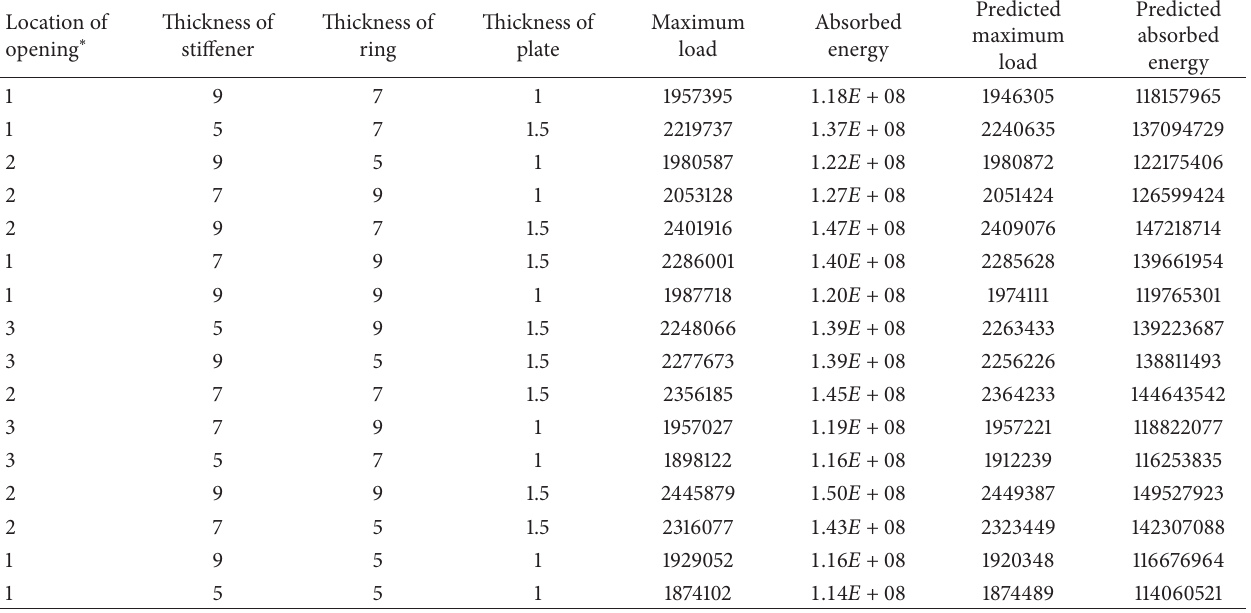
Table 4: The used data in order to test the